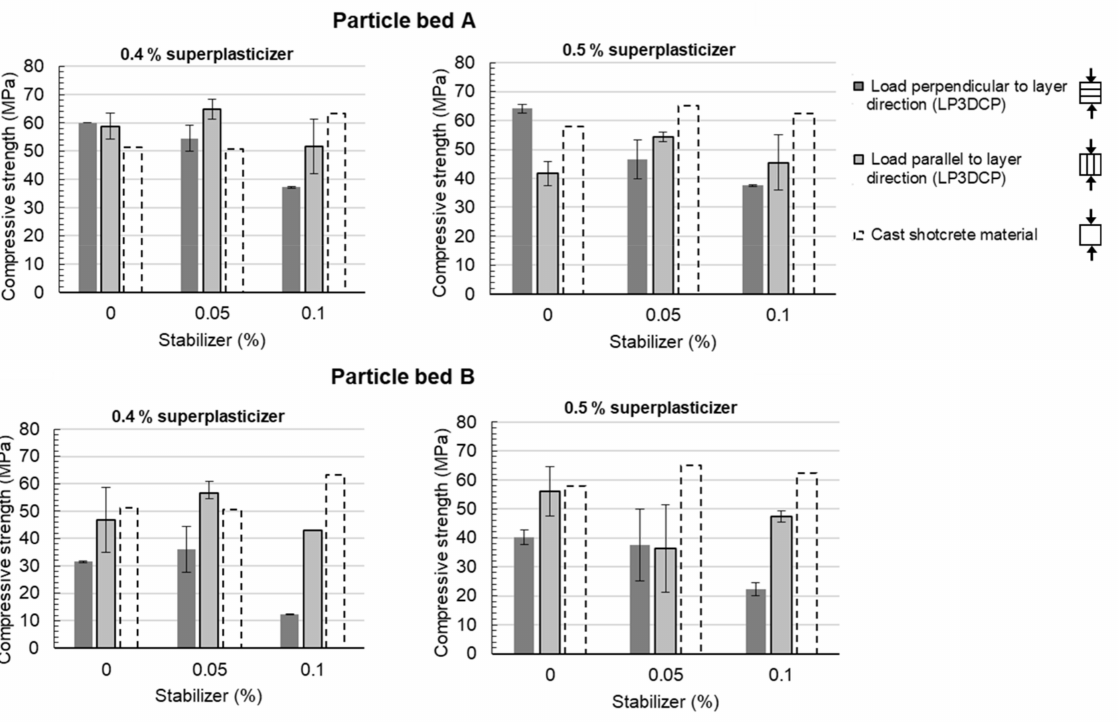
Figure 10. Compressive strength of LP3DCP specimens for particle bed A ( top ) and B ( bottom ), superplasticizer dosage 0.4% ( left ) and 0.5% ( right ), load direction perpendicular (dark grey bars) and parallel (light grey bars) to the layer orientation as well as compressive strength of the pure shotcrete material without coarse recycled aggregates conventionally cast in moulds (dashed